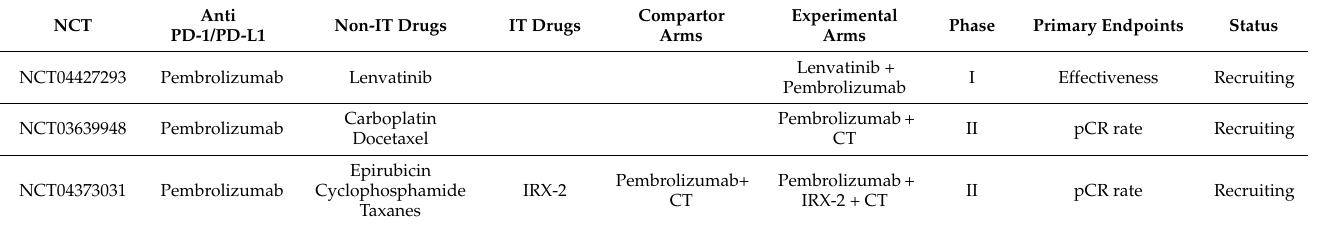
Table 2. List of completed or ongoing clinical trials with immune checkpoint inhibitors alone or with combinational drugs and novel immune-modulating strategies for early TNBC